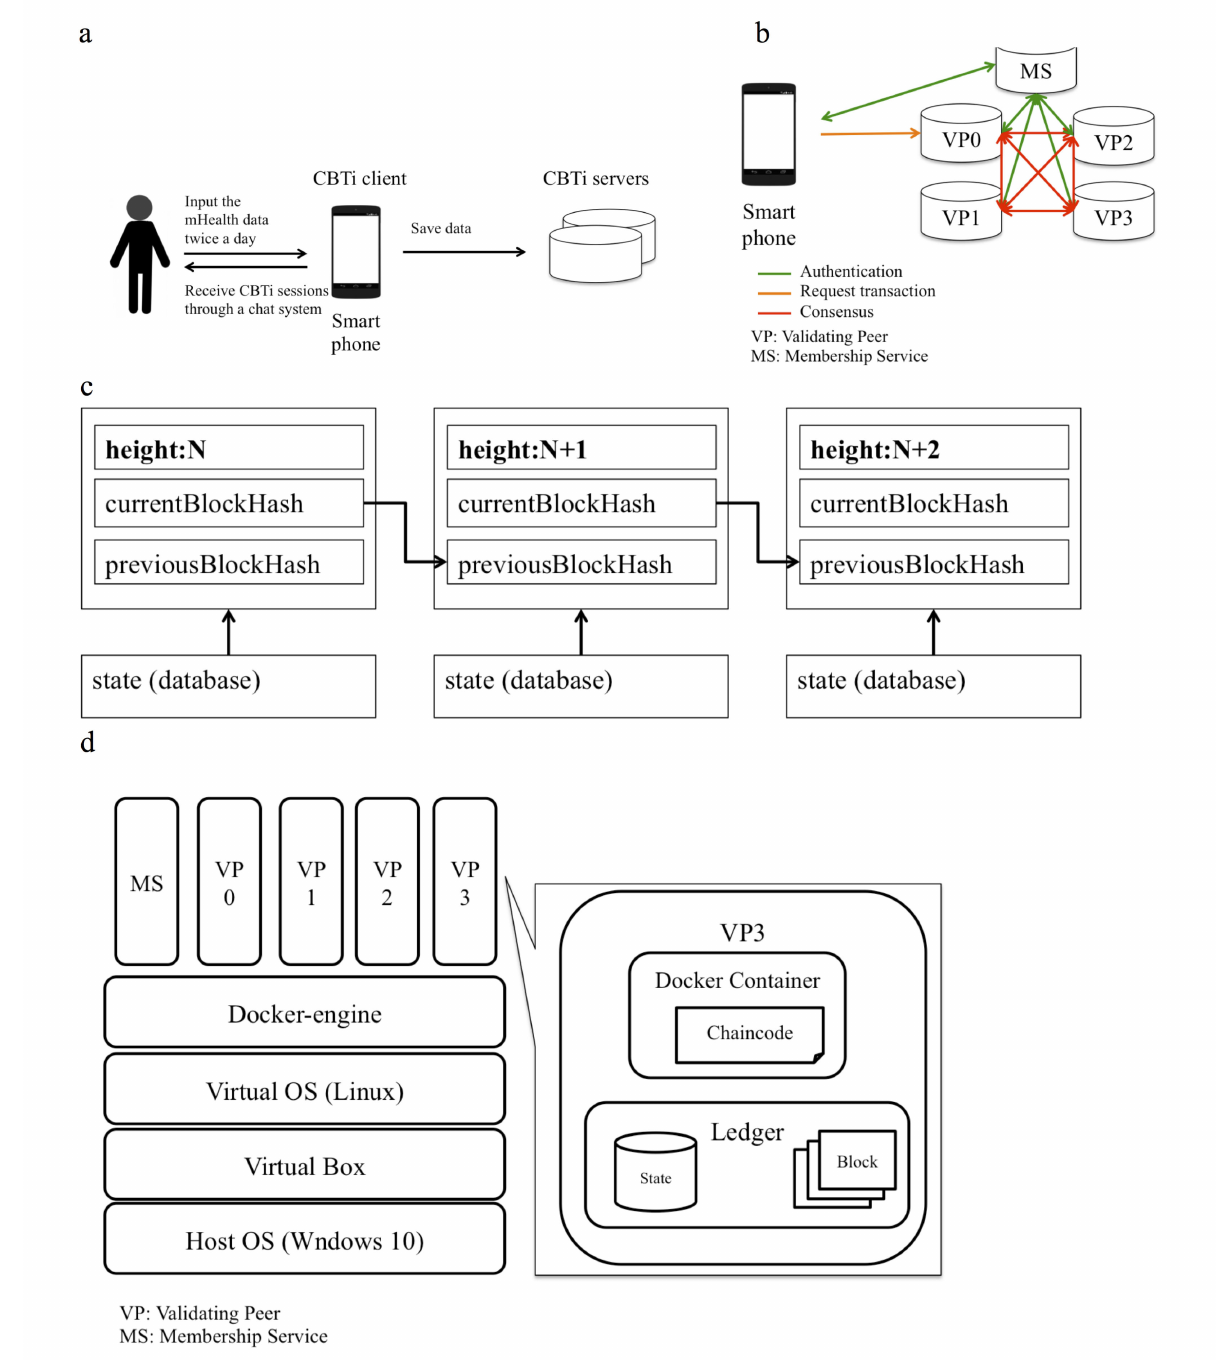
Figure 1. (a) The structure of the mobile health system for cognitive behavioral therapy for insomnia (b) The data update using a blockchain system (c) The structure of the blockchain (d) The virtual computing environment in the